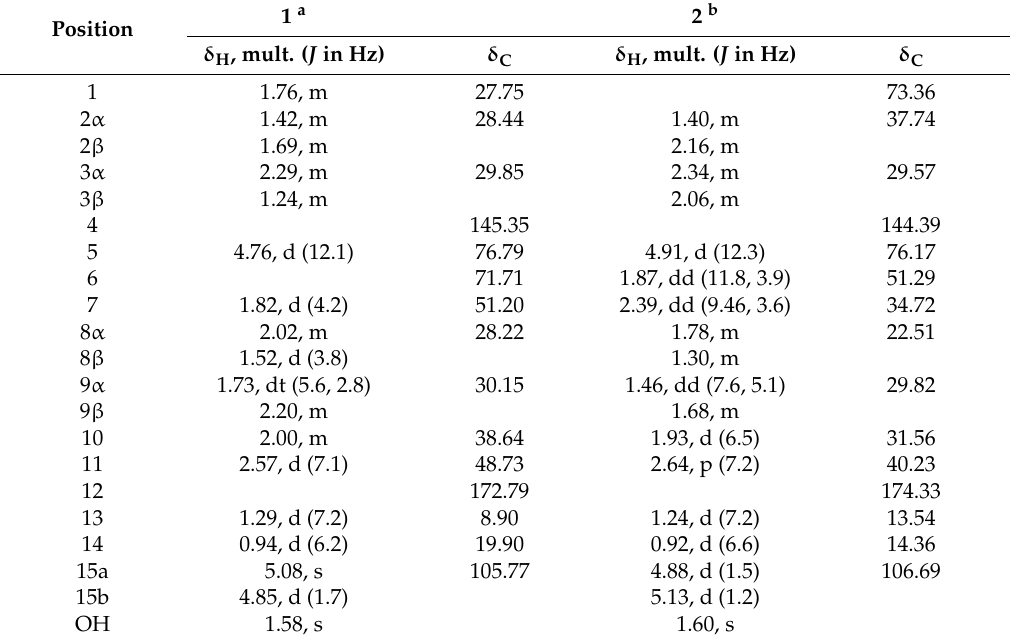
Table 1. 13 C and 1 H-NMR data for compounds 1 and 2 (in CDCl 3 ).